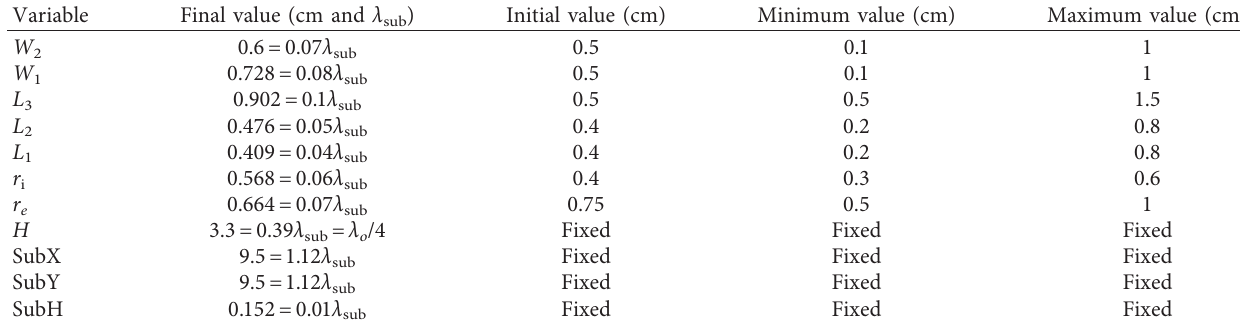
Table 3: Ranges of geometry dimensions for UCPCA optimization.